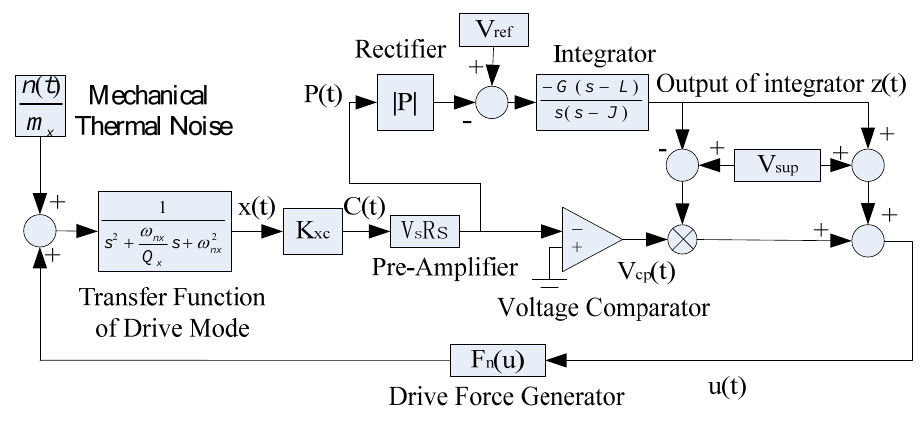
Figure 3. The frame of the closed-loop